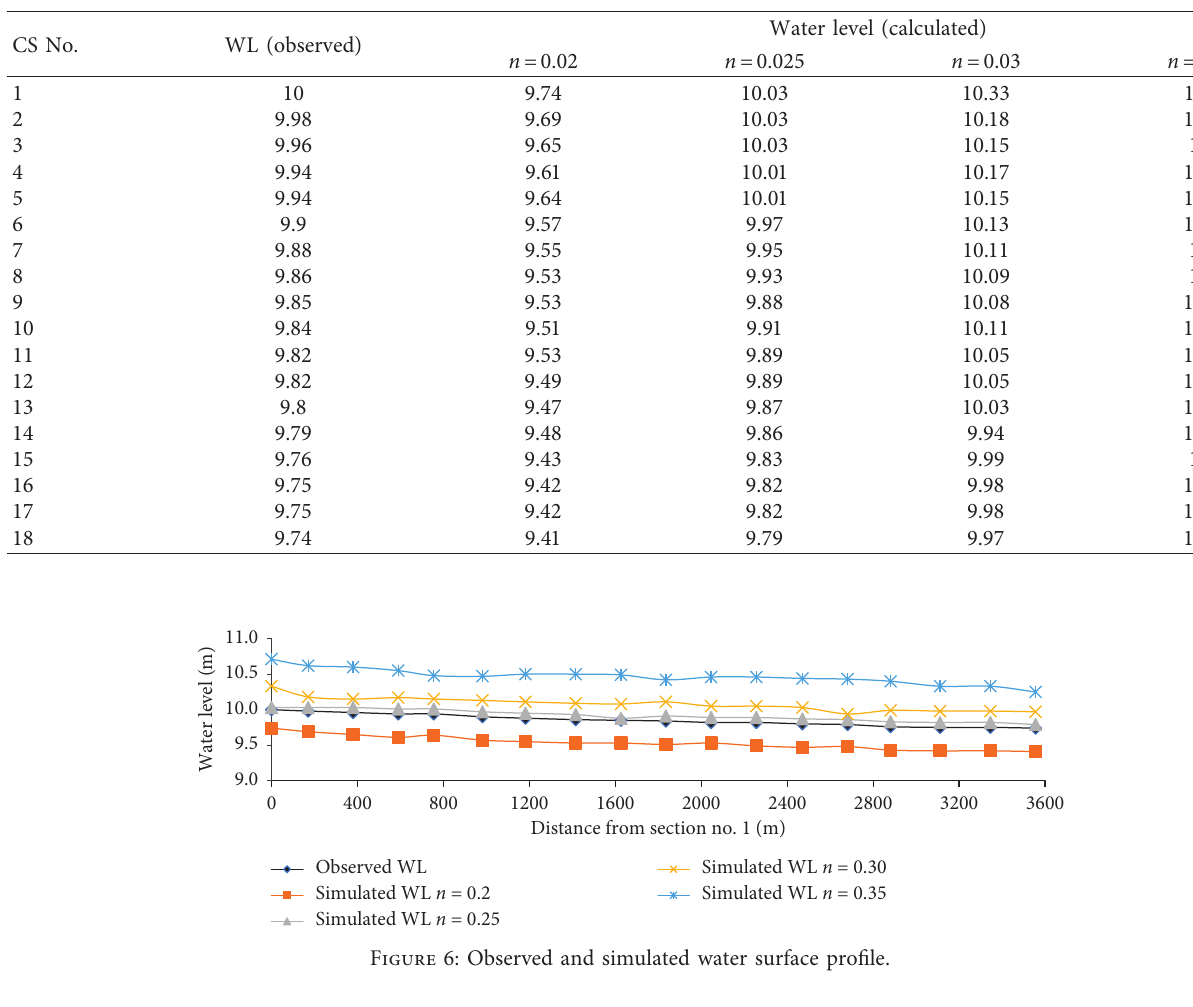
Table 1: Observed and calculated WL for different Manning’s n .